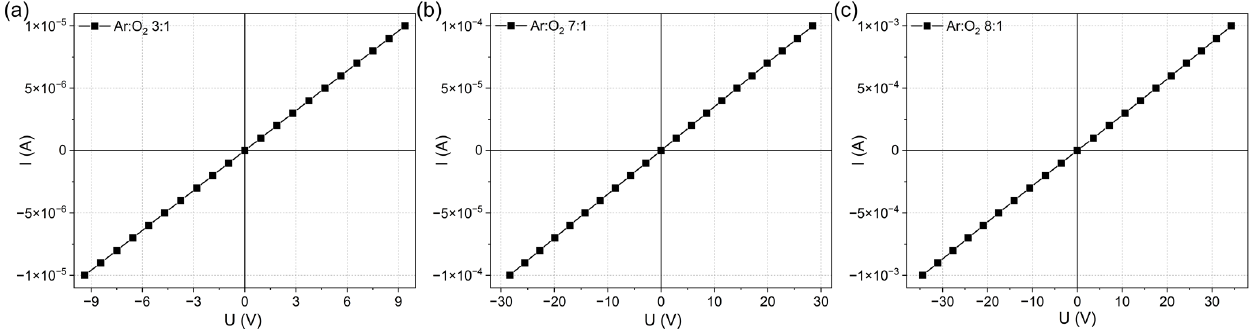
Figure 7. Current-voltage characteristics of selected V x O y thin films prepared with Ar:O 2 gas ratios of: ( a ) 3:1, ( b ) 7:1 and ( c ) 8:1.